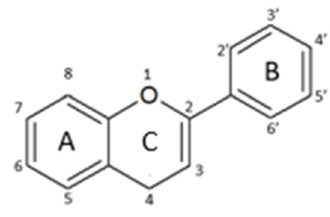
Figure 1. General structure of a flavonoid. Table 1. Structure of the main flavonoid compounds. Based on their structural differences, flavonoids can be divided into flavones, flavonols, flavanones, isoflavonoids, flavanols, and anthocyanins. Flavonoids whose epigenetic action is detailed in the text are in bold.